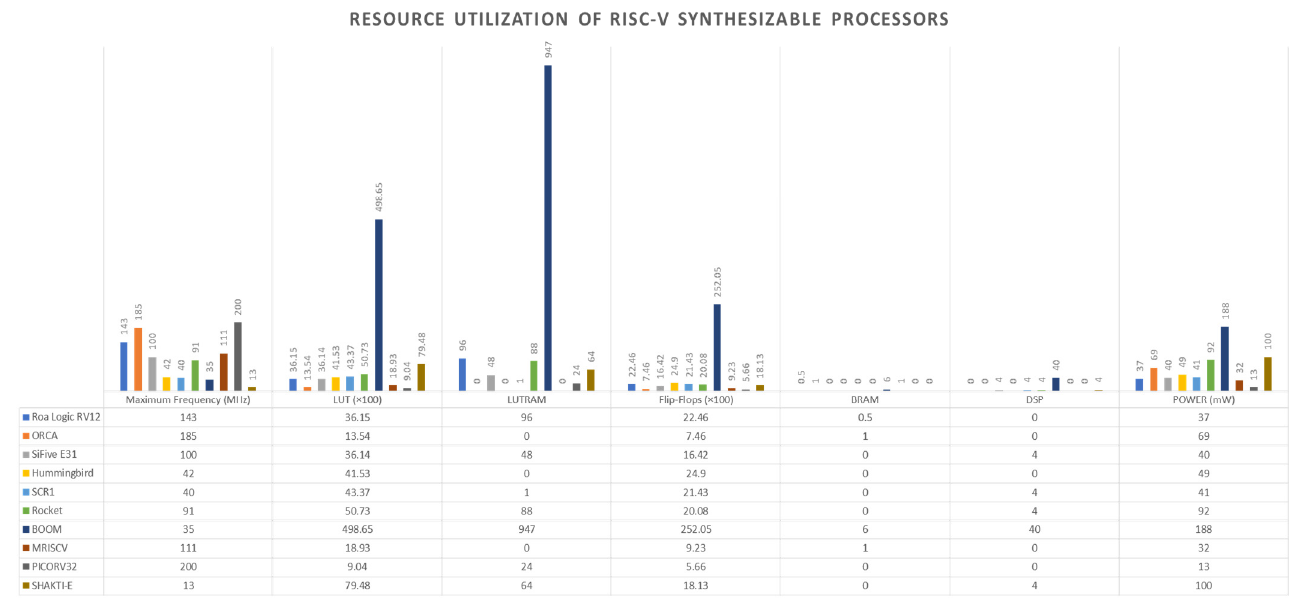
Figure 17. Synthesis results of RISC-V processor cores.